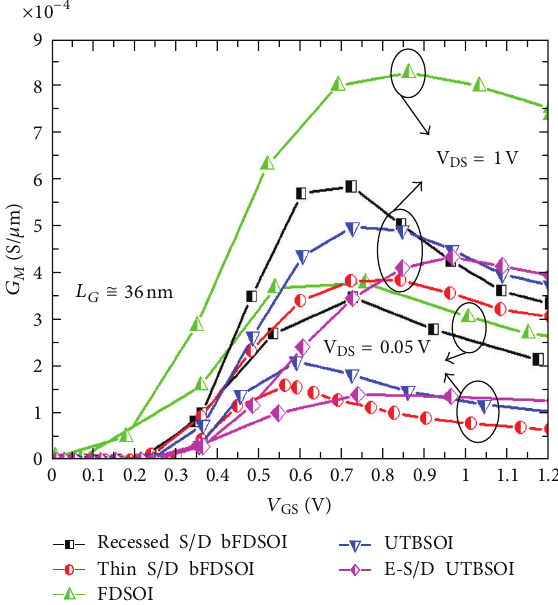
Figure 4: Comparison of bFDSOI and SOI MOSFETs 𝐺 𝑀 - 𝑉 characteristics with gate length 𝐿 𝐺 = 36